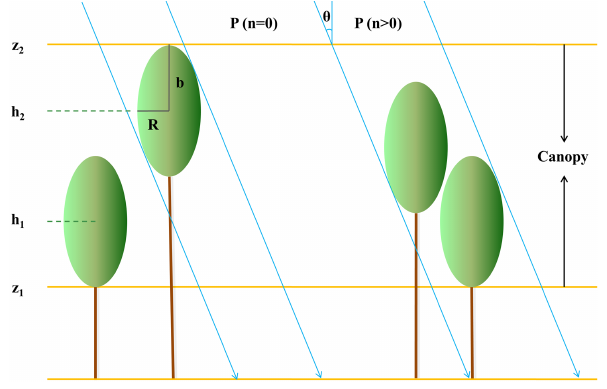
Figure 1. A scheme of the canopy structure in the Geometric Opti- cal Radiative Transfer model as modified from Ni